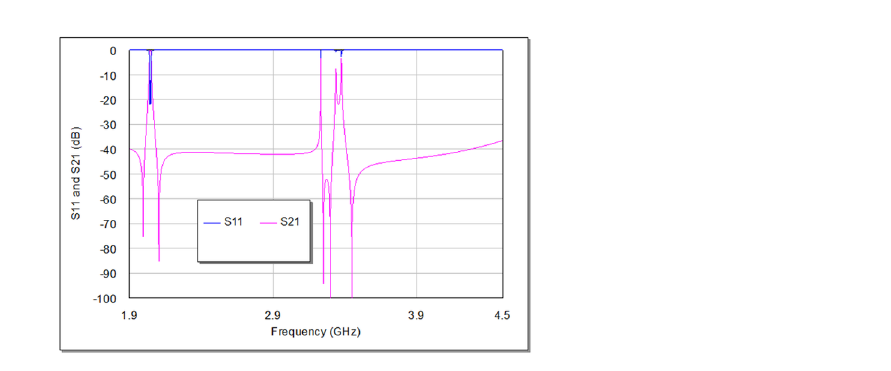
Fig 12. The out-of-band frequency responses of the proposed filter designed around 2 GHz fundamental frequency.